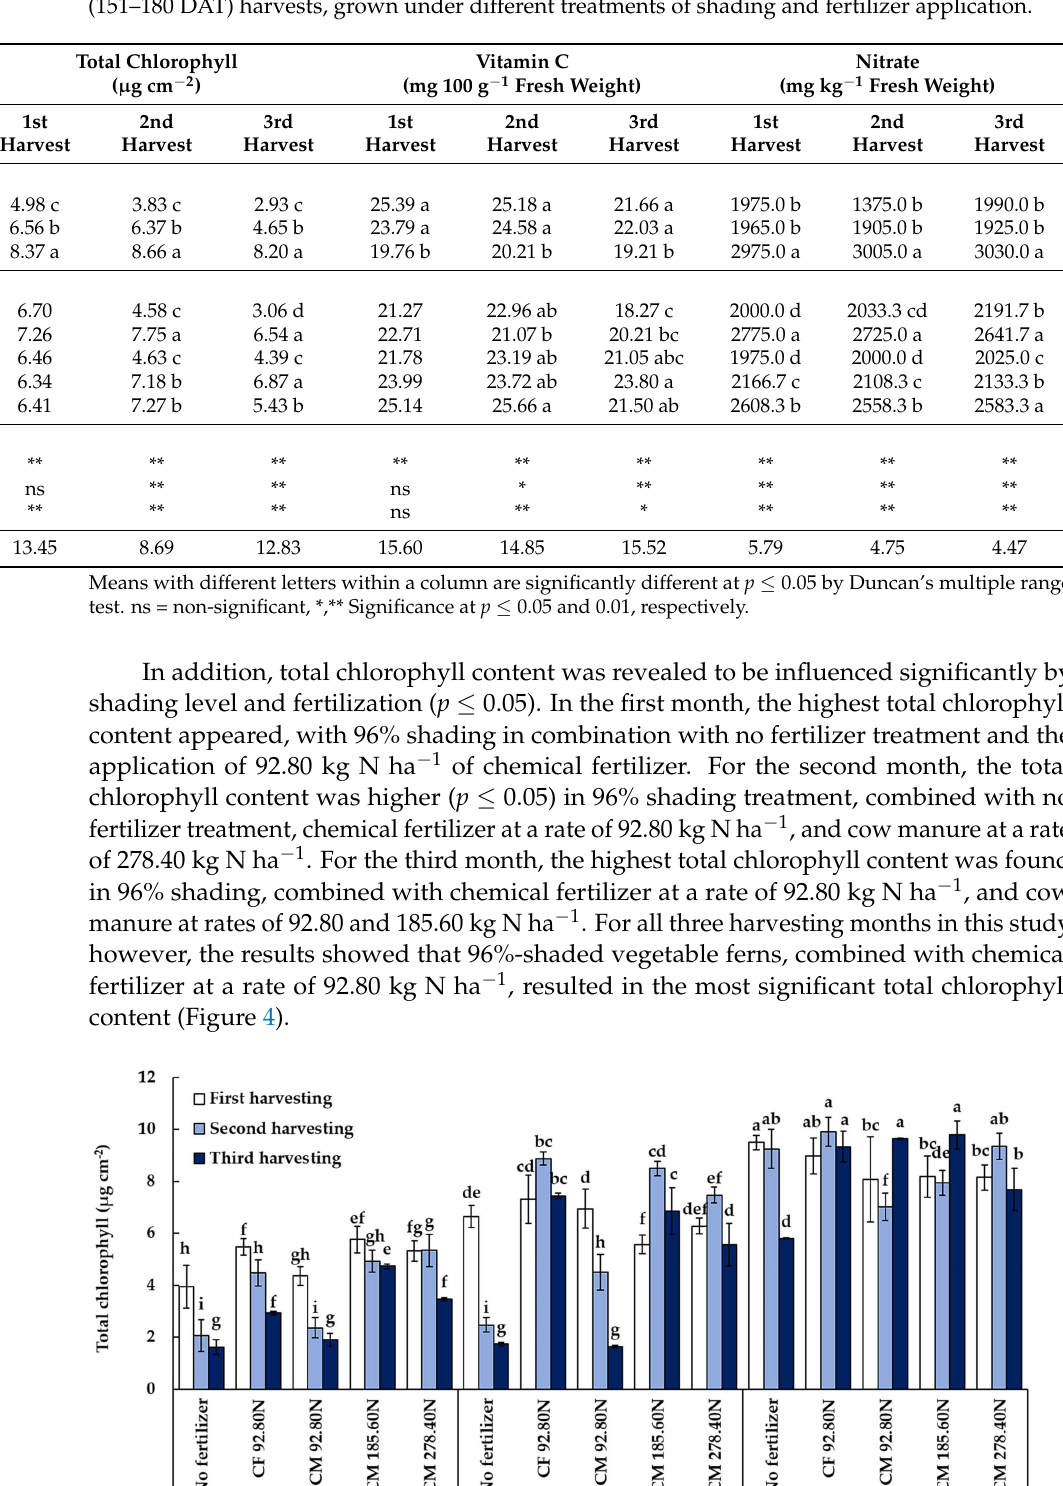
Table 4. Yield quality of vegetable fern at first (90–120 DAT), second (121–150 DAT), and third (151–180 DAT) harvests, grown under different treatments of shading and fertilizer application.